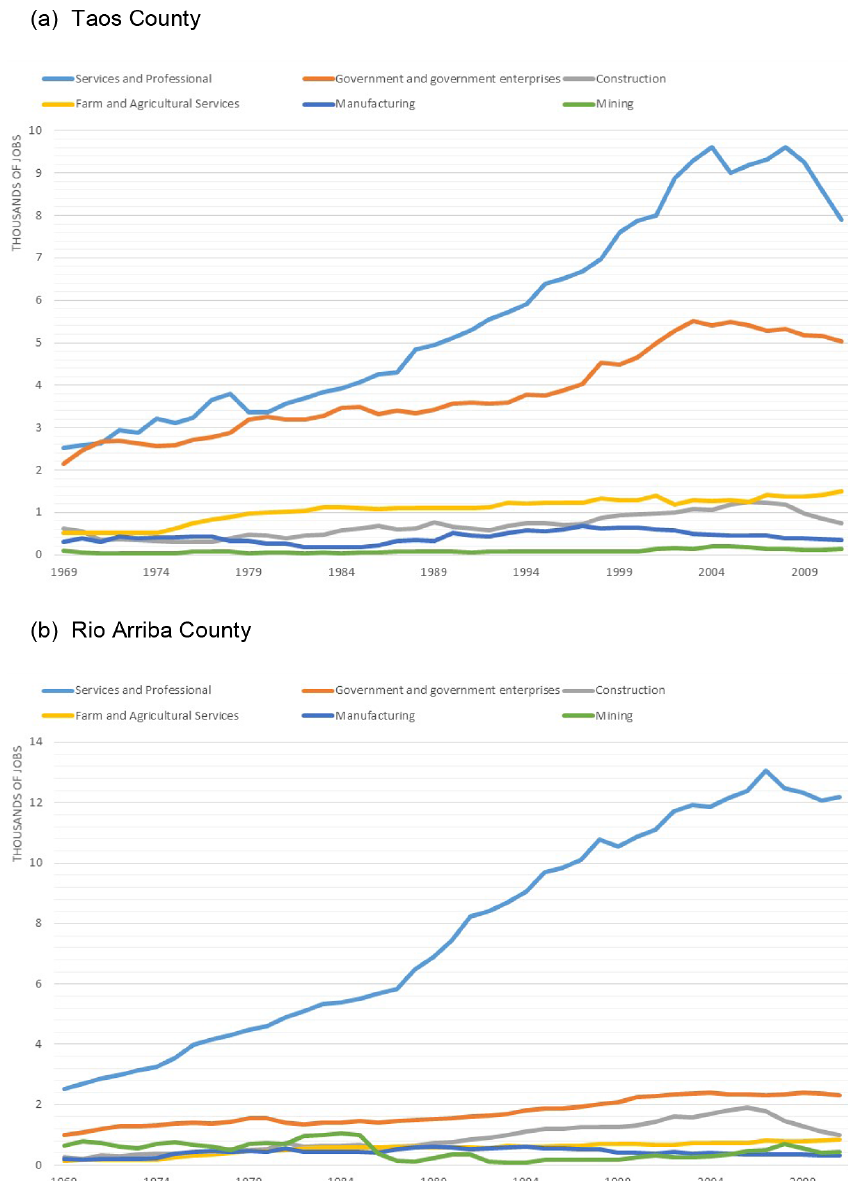
Figure 11. Employment shares and trends by sector in Taos and Rio Arriba Counties, New Mexico (US Bureau of Economic Analysis,